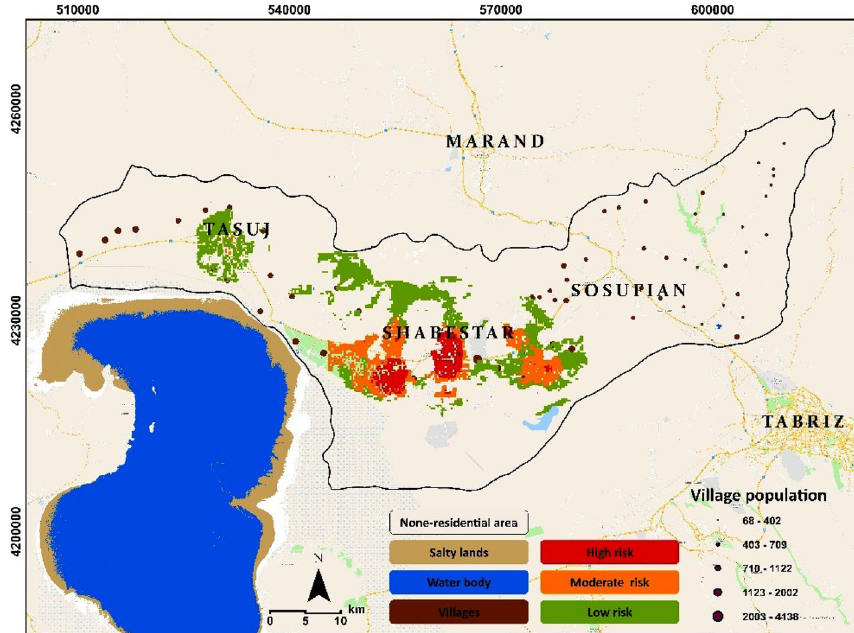
Figure 9. Results of GIS-MCDA-based vulnerability and health risk mapping based on the aggregation of the affecting environmental criteria as represented in Fig. 5. The map shows areas that face vulnerability and health risks due to salt-dust distribution. The map is created in ESRI- Arc GIS version 10.7 under licenses of Humboldt-Universität zu Berlin (https:// deskt op. arcgis.